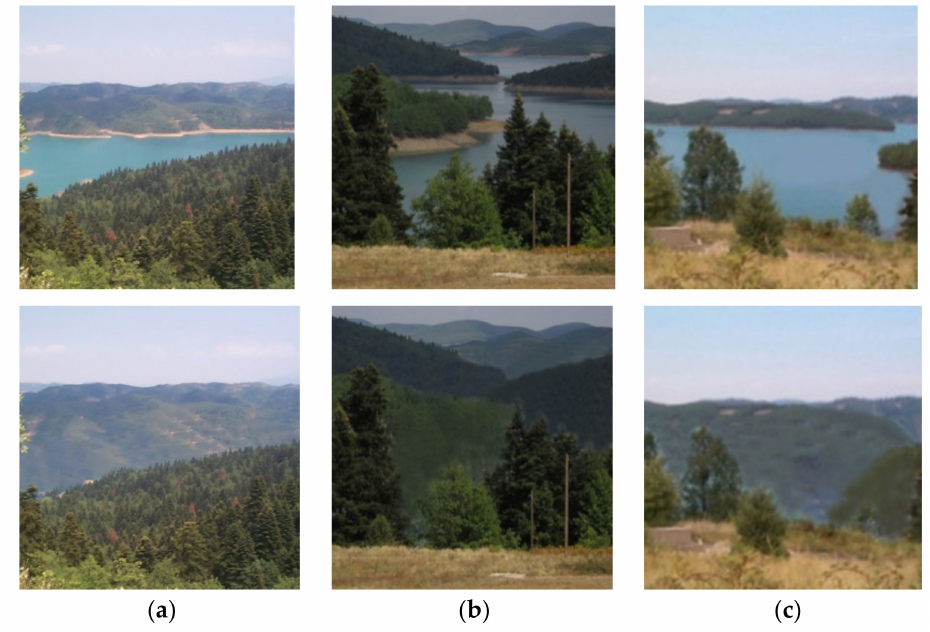
Figure 7. Plastiras reservoir south part; Viewpoints of Figure 6 ( a ) S.a; ( b ) S.b; ( c ) S.c; First row, original view; Second row, transformed images without